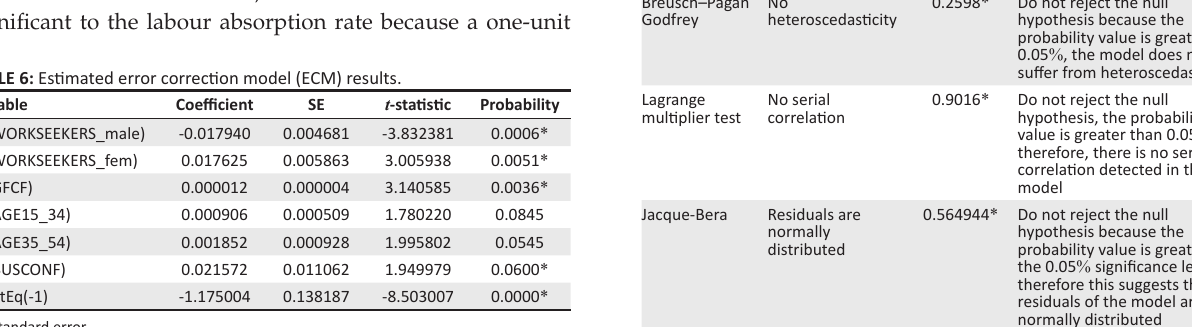
TABLE 7: Model diagnostic test results.